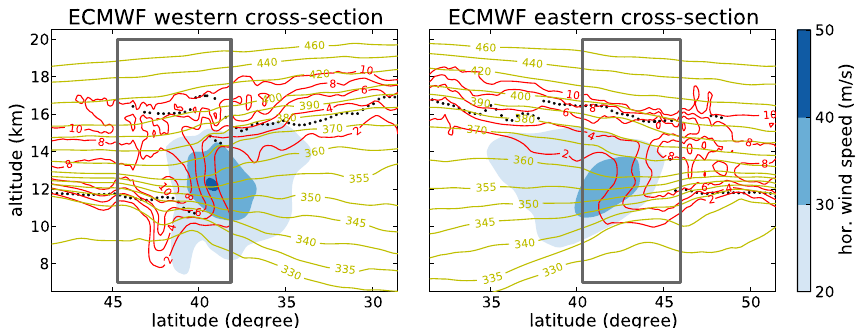
Fig. 3. Overview of meteorological situation on 29 July 2006 06:00UTC. Depicted are two vertical cross sections, the horizontal positions of which are indicated as yellow lines in Fig. 2. Blue surfaces show horizontal wind speed. Red contours show potential vorticity in PVU. Yellow contours indicate potential temperature in Kelvin. Black dots indicate the position of primary and secondary lapse-rate tropopause. The dark grey rectangle indicates the approximate position of the measured trace gas cross sections presented later on.